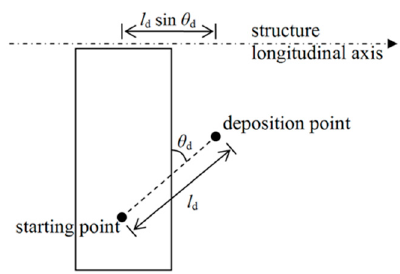
Figure 1. Definition sketch for the General Longshore Transport (GLT) model.